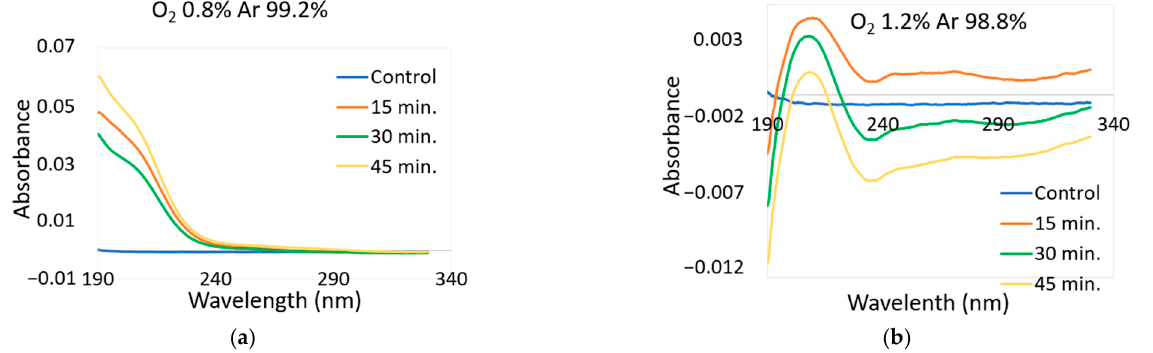
Figure 3. UV absorption spectra for PAW: ( a ) 0.8% O 2 and 99.2% Ar; ( b ) 1.2% O 2 and 98.8% Ar.